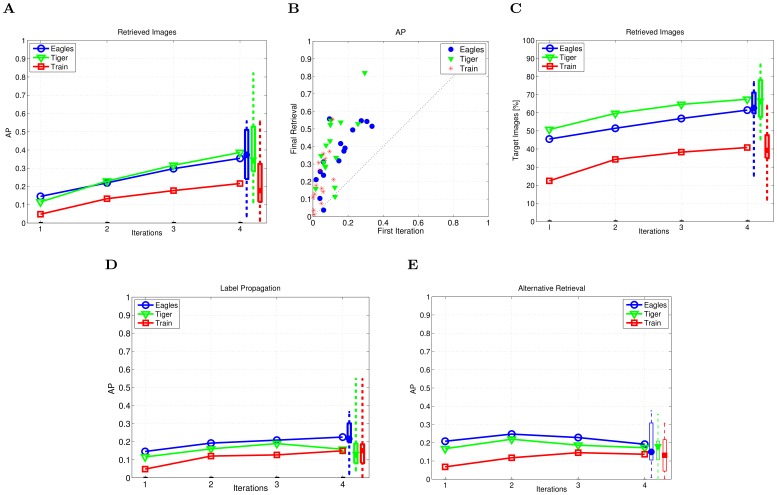
Closed-loop retrieval performance evaluated on testing tasks (i.e., “Eagles”, “Tiger” and “Train”).(A) Average precision by successive averaging. (B) Average precision of the 200 retrieved images after the first iteration vs the final retrieval (closed-loop with successive averaging). (C) Retrieved target images after each iteration in respect to the total number of targets in the database. (D) Average precision of the 200 top ranked images obtained by propagating only the harden EEG-based labels obtained for the last seen sequence; (E) Average precision of the 200 retrieved images using the approach for the iterative EEG-based image retrieval in [1]. Note that, after propagation of EEG-based labels, images in the database that were included in the presented RSVP sequences have the original soft EEG-based labels for this approach, while our approach assigns them hard labels. The rightmost side of the plots show the performance across subjects in the last iteration. The median (the central mark of the box), the 25th and 75th percentiles (the edges of the box) and the most extreme performance (dashed lines) across subjects, are reported per search task for the final database ranking.